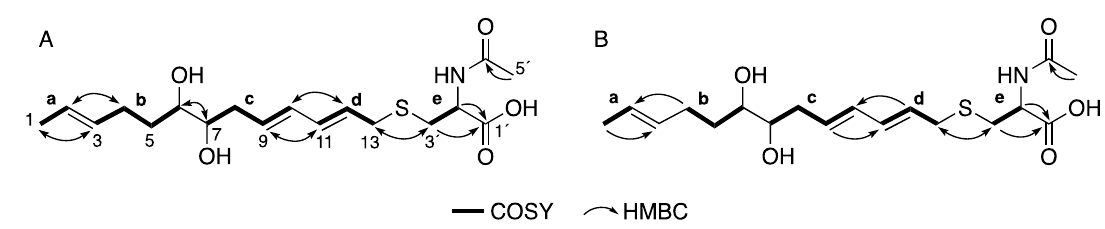
Figure 2. 2D NMR correlations of 1 ( A ) and 2 ( B ).